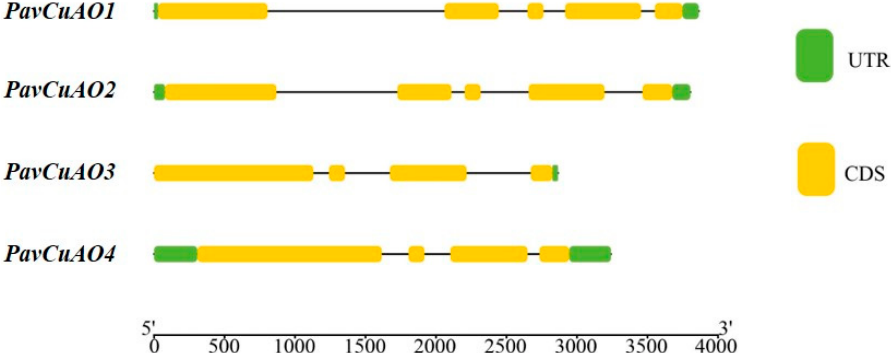
Figure 1. Gene structure of PavCuAOs in sweet cherry.